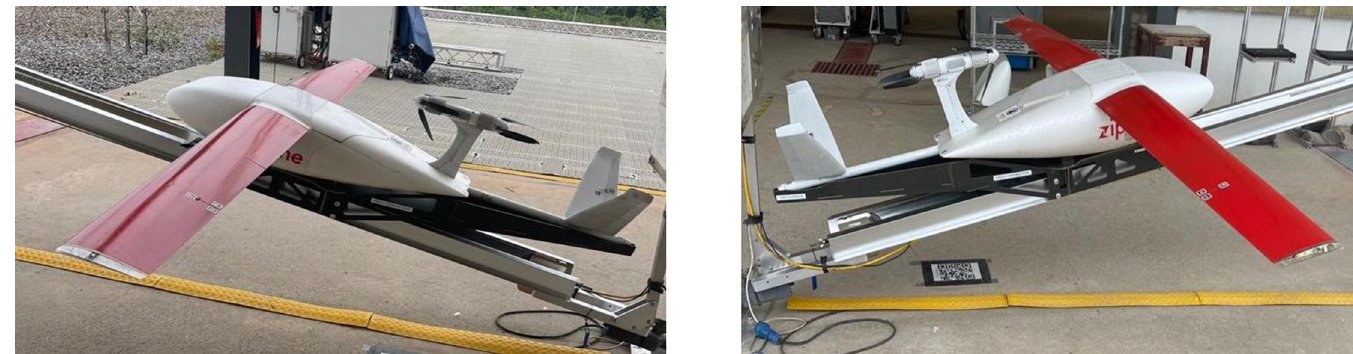
Fig 1. Pictures of some of the drones used by Zipline (pictures taken by Bonsu F.O).